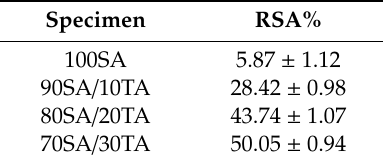
Table 2. Antioxidant activity (RSA%) of sodium alginate / tannic acid films.